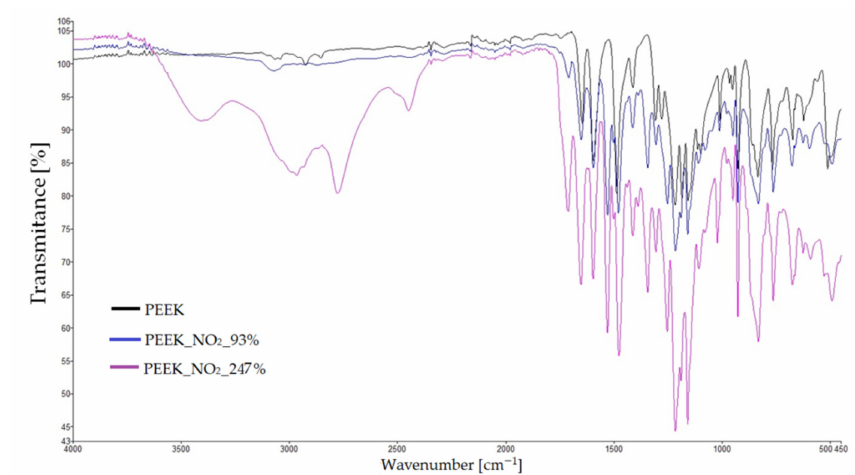
Figure 10. FT-IR spectra of PEEK_NO 2 —93% and PEEK_NO 2 —247% compared to that of pure